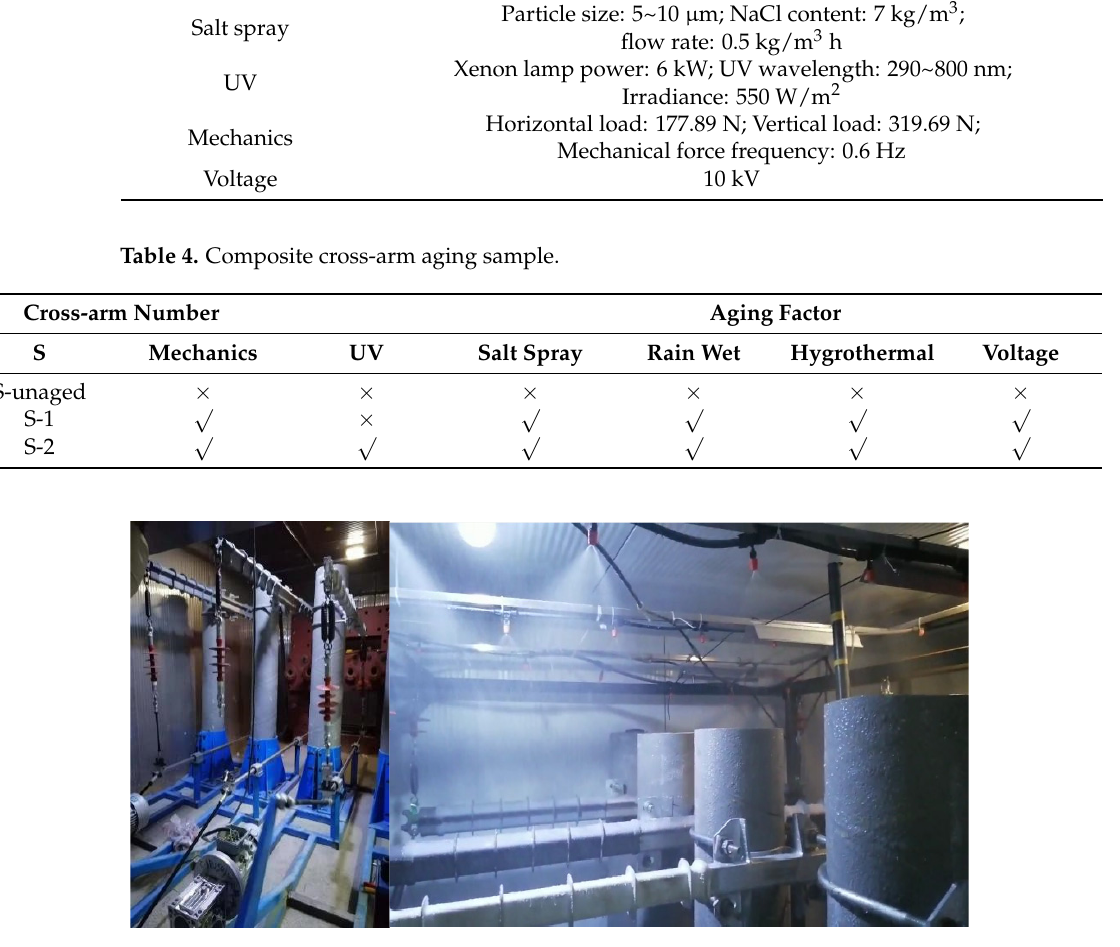
10 kV Table 4. Composite cross-arm aging sample. Cross-arm Number